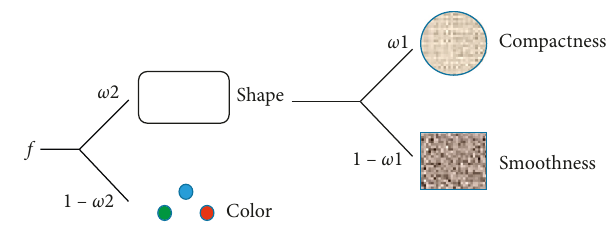
Figure 6: Heterogeneity diagram.